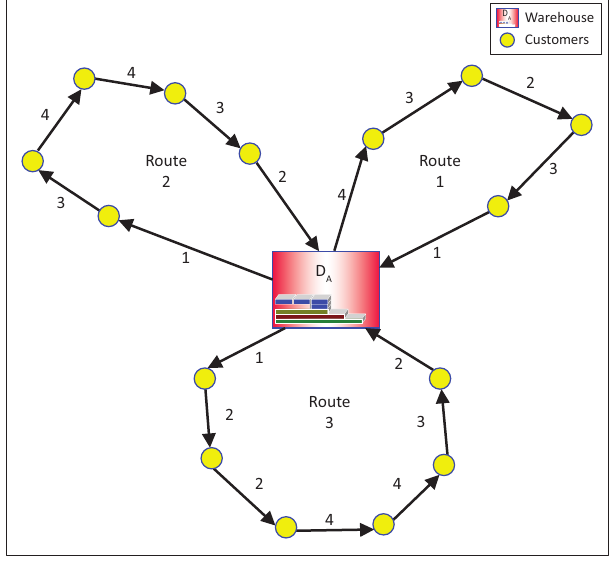
FIGURE 1: Example of the Capacitated Vehicle Routing Problem with three routes (served by three